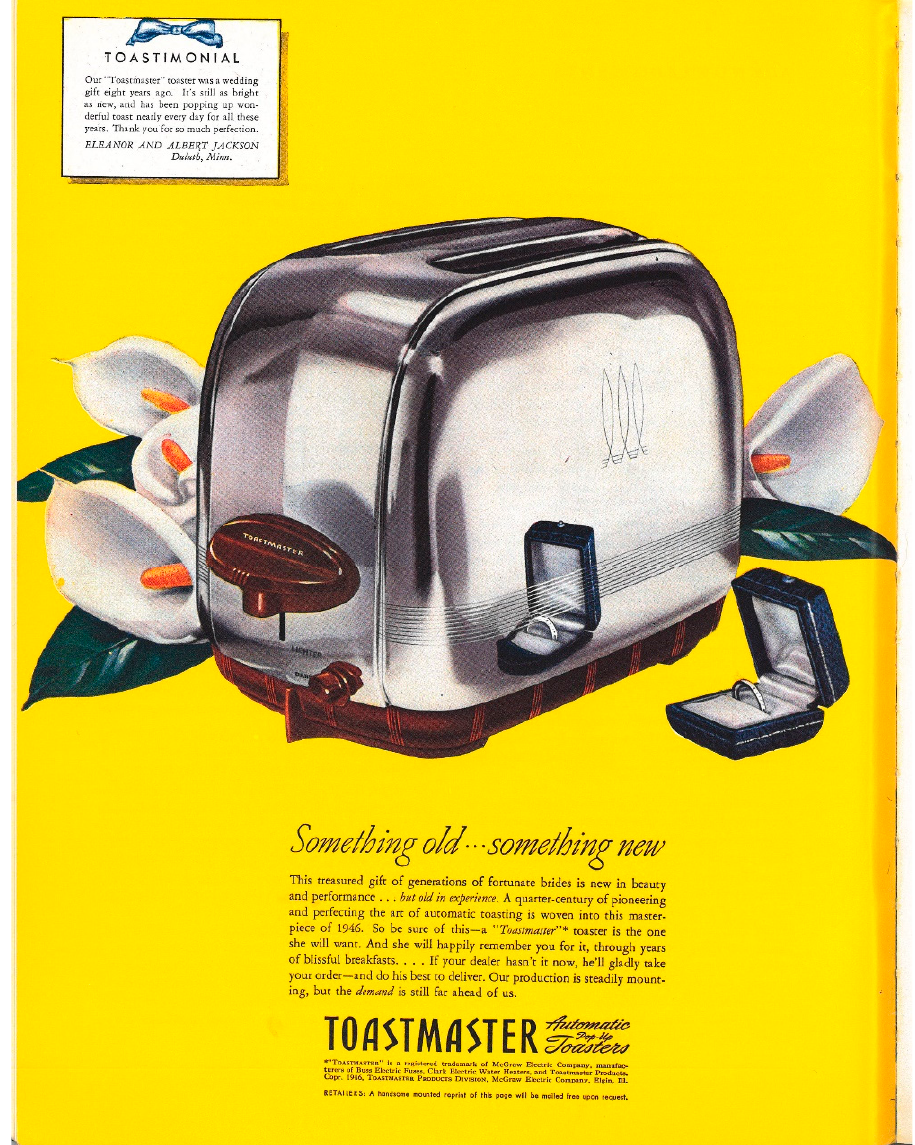
Figure 1. This 1946 ad included in the Mechanical Brides (Lupton 1993, p. 6) exhibit describes the toaster as a family legacy or sentimental keepsake one might find in a hope chest.